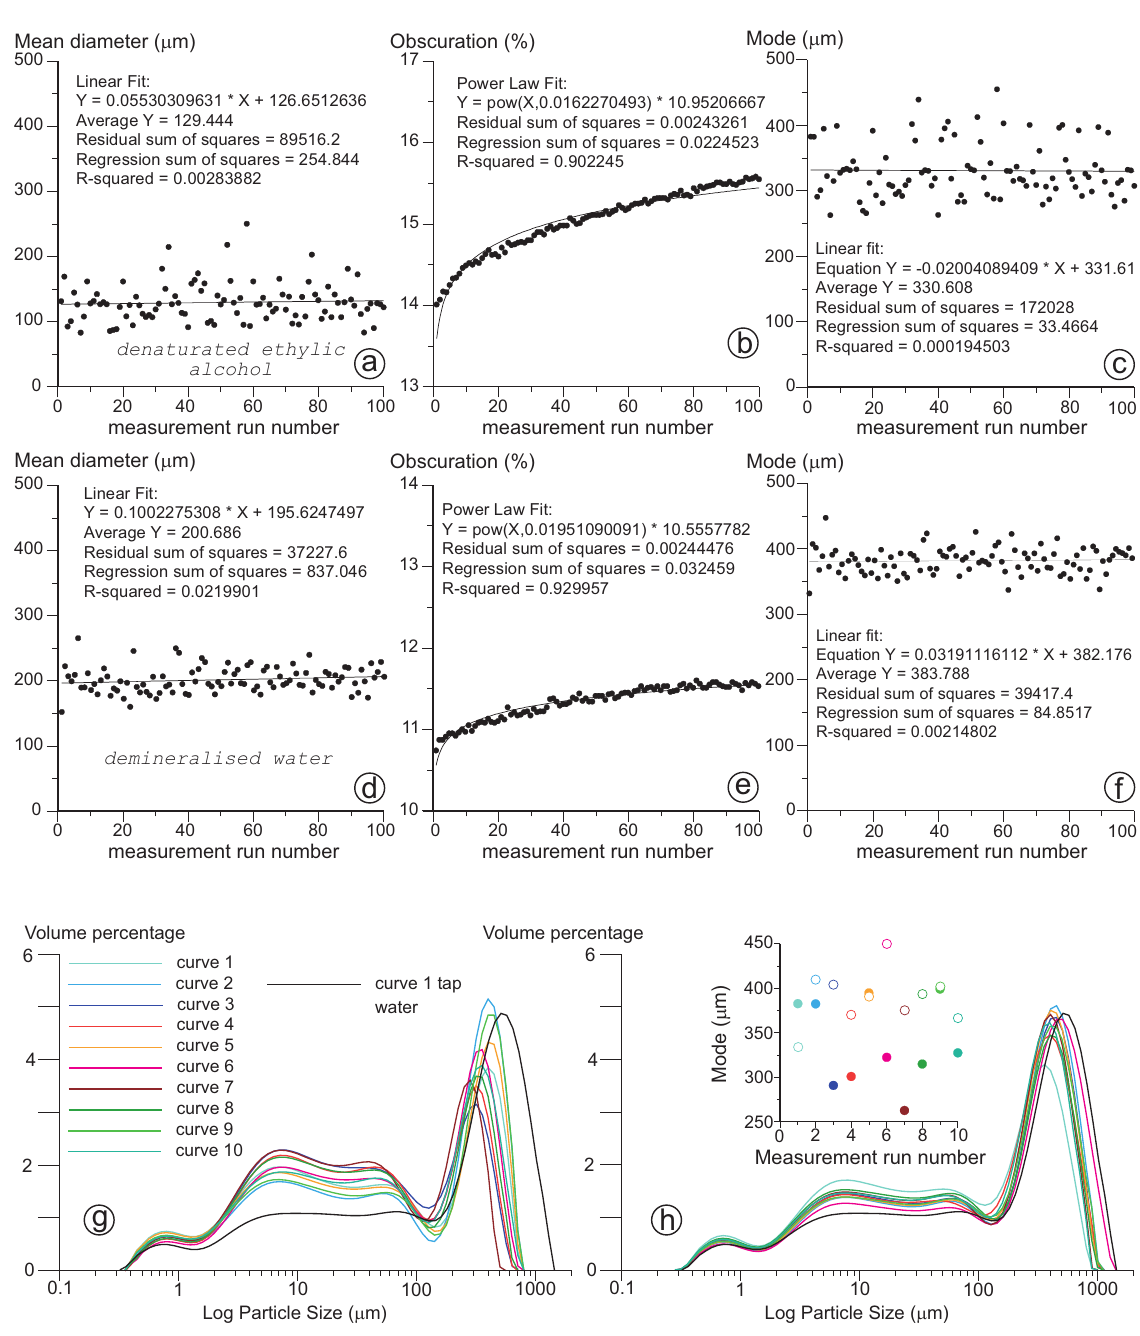
Fig. 19. Results of chemical tests performed on sample CABRE3e by the Hydro 2000 MU dispersion unit. (a) Test MP2000 5al performed on sub-sample aliquot CABRE3p using denaturated ethyl alcohol as dispersant liquid; mean diameter value evolution with increasing the number of measurement runs. Data statistics are provided. (b) Laser obscuration value progression during the same test. Data statistics are provided. (c) Progression of modal values with increasing the number of measurement runs. Data statistics are provided. (d) Test MP2000 5dw performed on sub-sample aliquot CABRE3q using demineralised water as dispersant liquid; mean diameter value evolution with increasing the number of measurement runs. Data statistics are provided. (e) Laser obscuration value progression during the same test. Data statistics are provided. (f) Progression of modal values with increasing the number of measurement runs. Data statistics are provided. (g) Granulometric curves computed for the first 10 runs in (a), compared with the first curve from the test MP2000 5 on sub-sample aliquot CABRE3d (Fig. 9). (h) Granulometric curves computed for the first 10 runs in (d), compared with the first curve from the test MP2000 5 on sub-sample aliquot CABRE3d (Fig. 9). The inset graph show the comparison between modal values corresponding to the curves in (g) (filled dots) and in (h) (empty